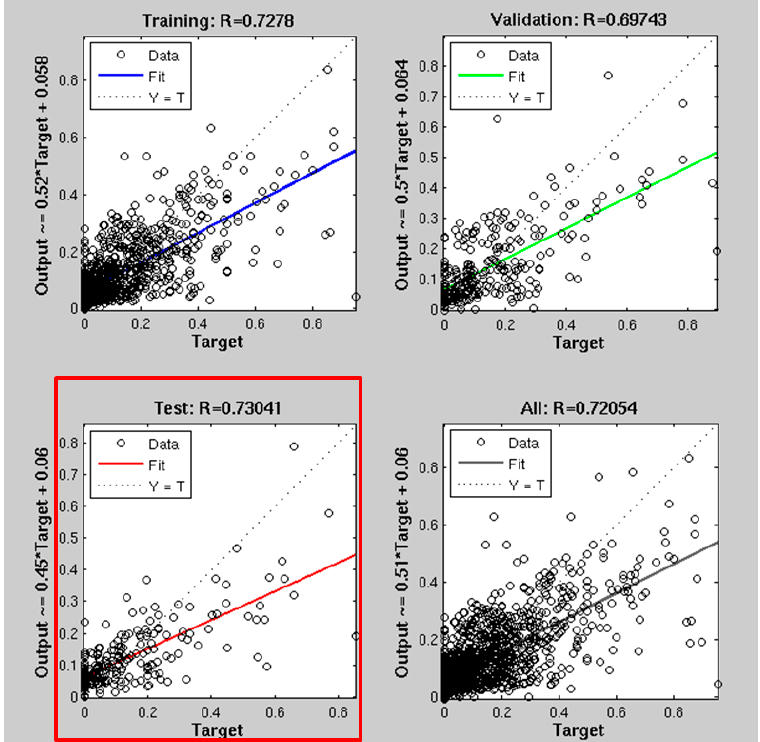
Figure 5. Regression curves for training, validation, test, and total sets, considering Exp 2. Red squared regression curves describe the result obtained when an independent dataset is applied.